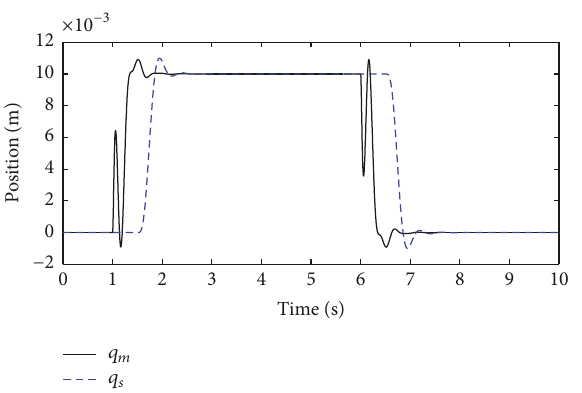
Figure 13: Position tracking performance ( 𝑇 1 = 0.5 s ,𝑇 2 = 2 s).